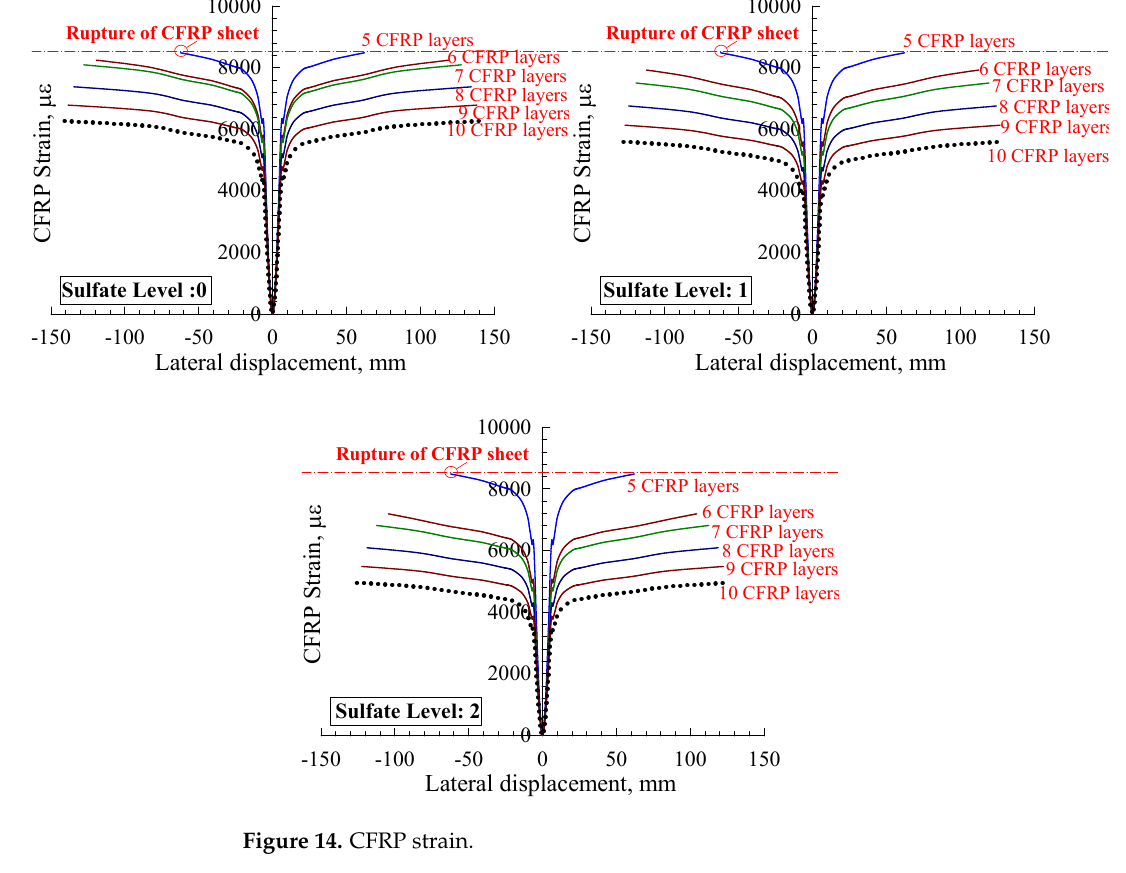
Figure 14. CFRP strain.